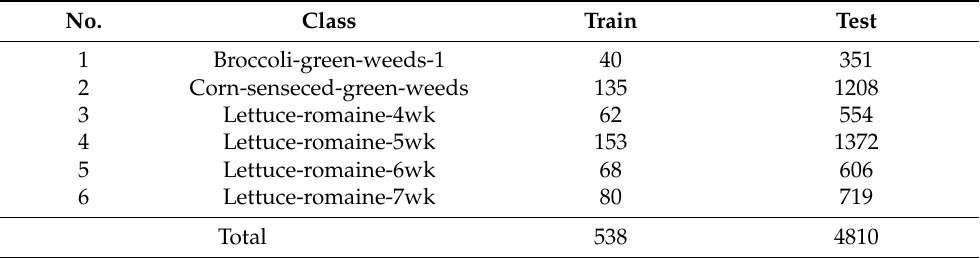
Table 1. Land cover class information for the SAC dataset.